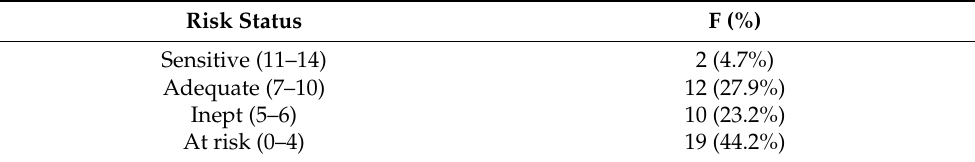
Table 6. Frequencies and percentages of mother–infant interaction categories ranked according to the dyadic sensitivity score (N =